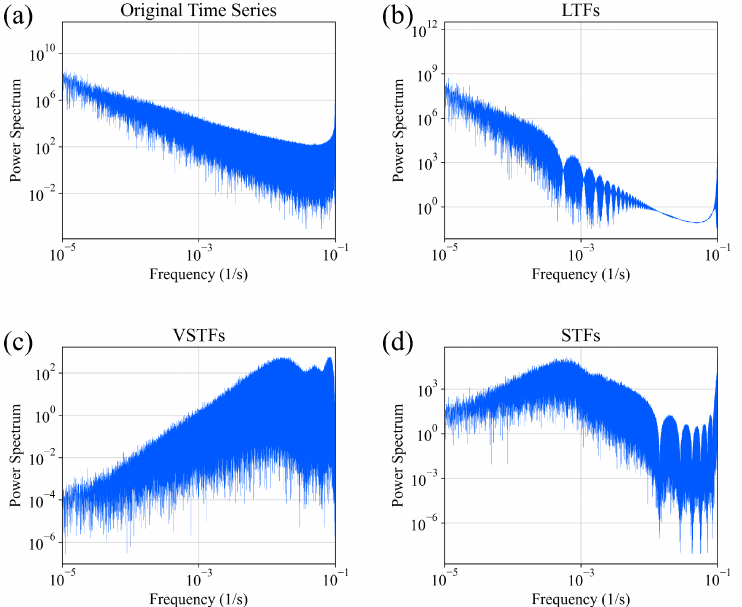
Figure 5. ( a ) Power spectra of the time series of wind power output and ( b ) long-, ( c ) very short-, and ( d ) short-term fluctuations in the Tohoku area in the 2012 fiscal year. Microscopically, the time series of STFs consist of multiple half-cycles. Each half-cycle has an amplitude, ∆ p , and a period, τ , as shown in Figure 6, which contains more than three half-cycles. The timescale of STFs is double the length of τ , thus, the period of a whole cycle.